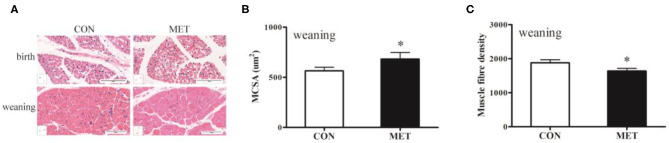
Effects of maternal MET supplementation during gestation on histological properties in offspring longissimus dorsi muscle. Data are reported as means ± standard deviation, n = 12 at birth; n = 8 at weaning. (A) Representative hematoxylin and eosin (H&E) staining of newborn and weaning piglets. (B) Number of muscle fibers per mm2 of weaning offspring. (C) Muscle fiber cross-sectional area of weaning offspring. CON, control diet; MET, methyl-donor micronutrients diet. *P < 0.05 (significant differences between MET vs. CON).